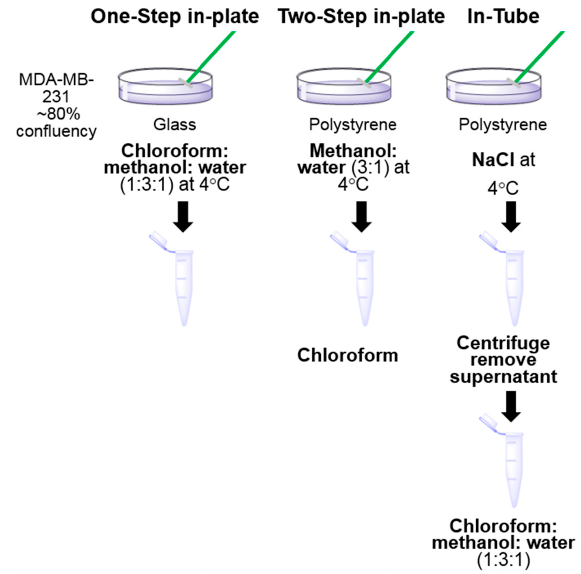
Figure 1 . Workflow of metabolite extraction methods. For the one-step in-plate method, MDA-MB- cells grown in glass dishes were scraped in chloroform:methanol:water (1:3:1) for